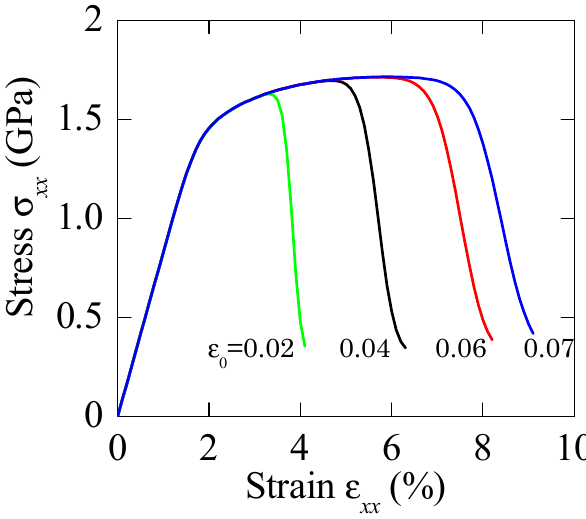
Figure 5. Stress–strain relations of BMGCs with different Weibull modulus m , where ε 0 = 0.06 is adopted. The impacts of model parameters in the present method should be carefully explained.